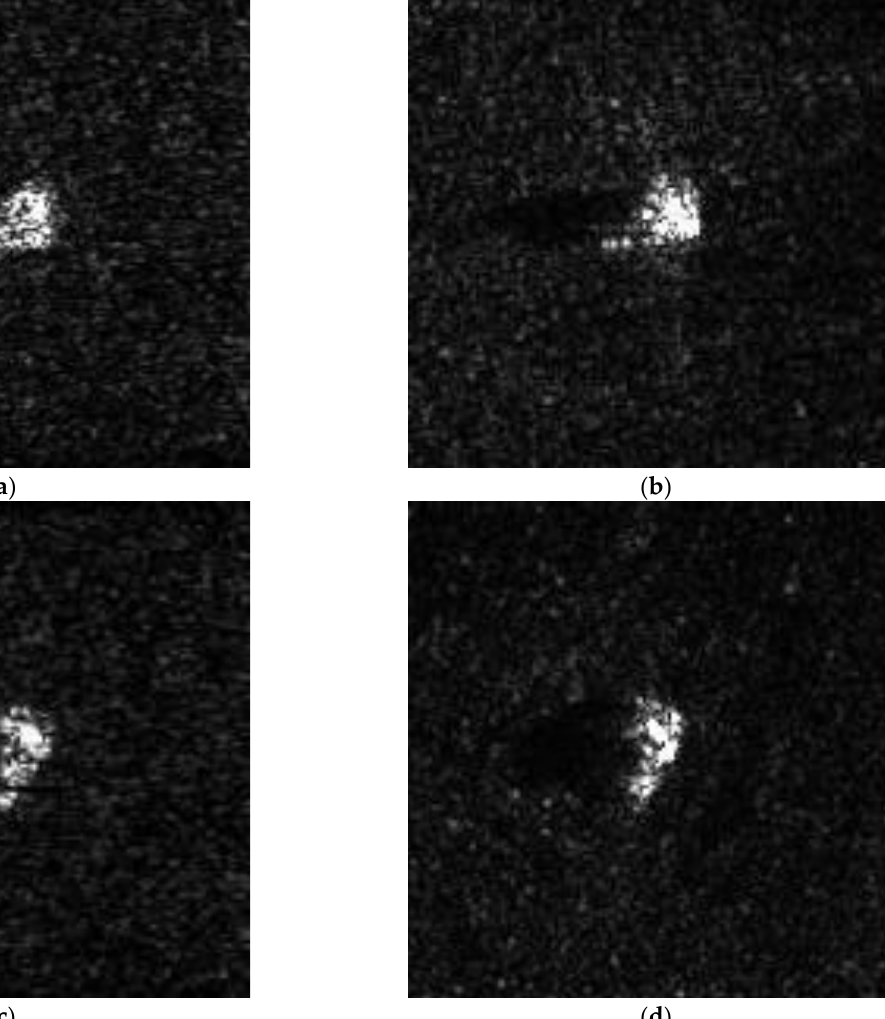
Figure 13. Similarity between simulated image and MSTAR data: ( a ) φ ( b ) φ a = 15 ◦ MSTAR data; ( c ) φ a = 60 ◦ simulated image; ( d ) φ a = 60 ◦ MSTAR